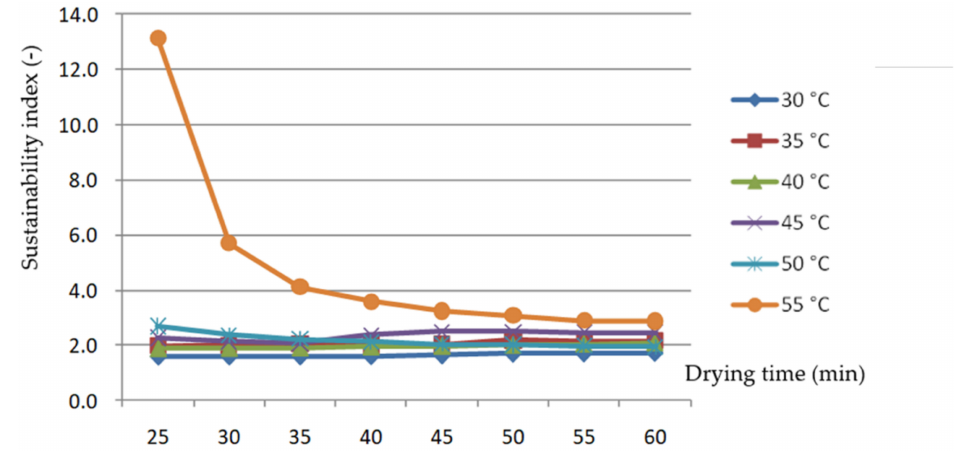
Figure 11. Changes in the sustainability index changes with drying time at different air